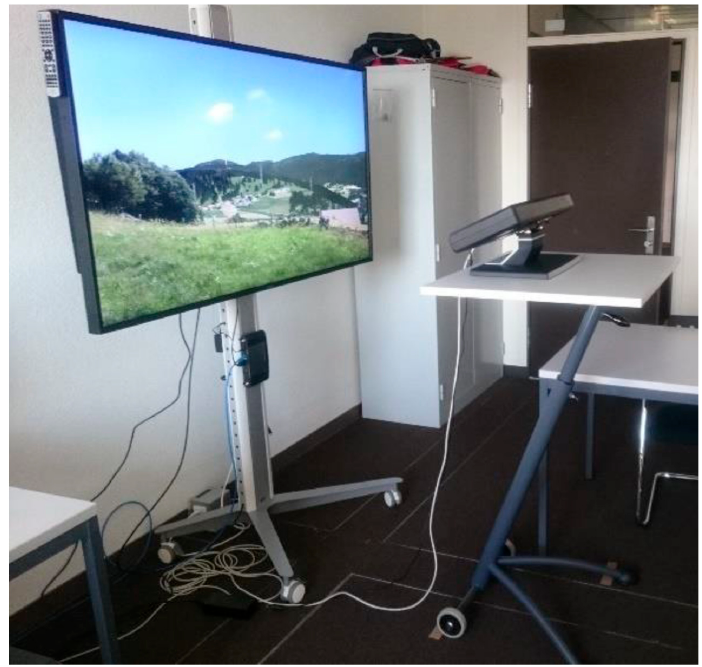
Figure 2. Arrangement of the equipment for the eye tracking study. (Photo: Kilian Müller 2018).